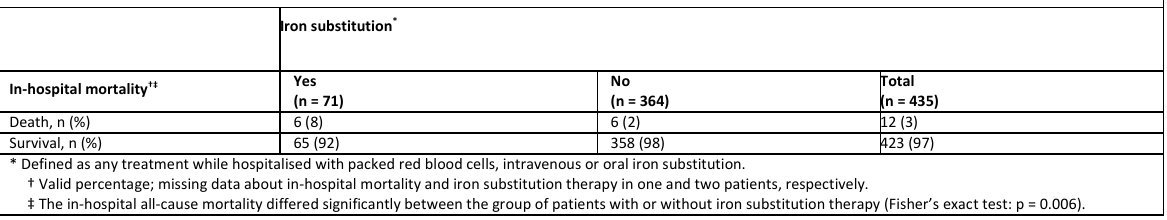
In-hospital mortality †‡